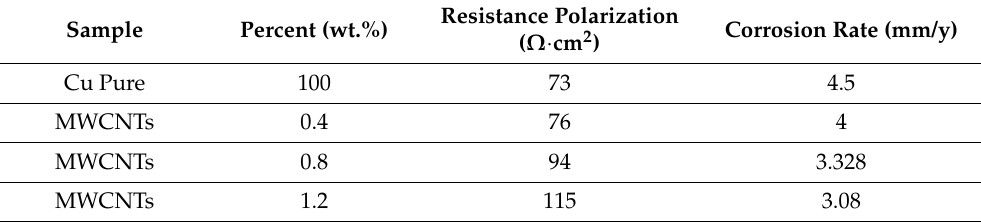
Table 4. The resistance polarization and corrosion rate of Cu reinforced with